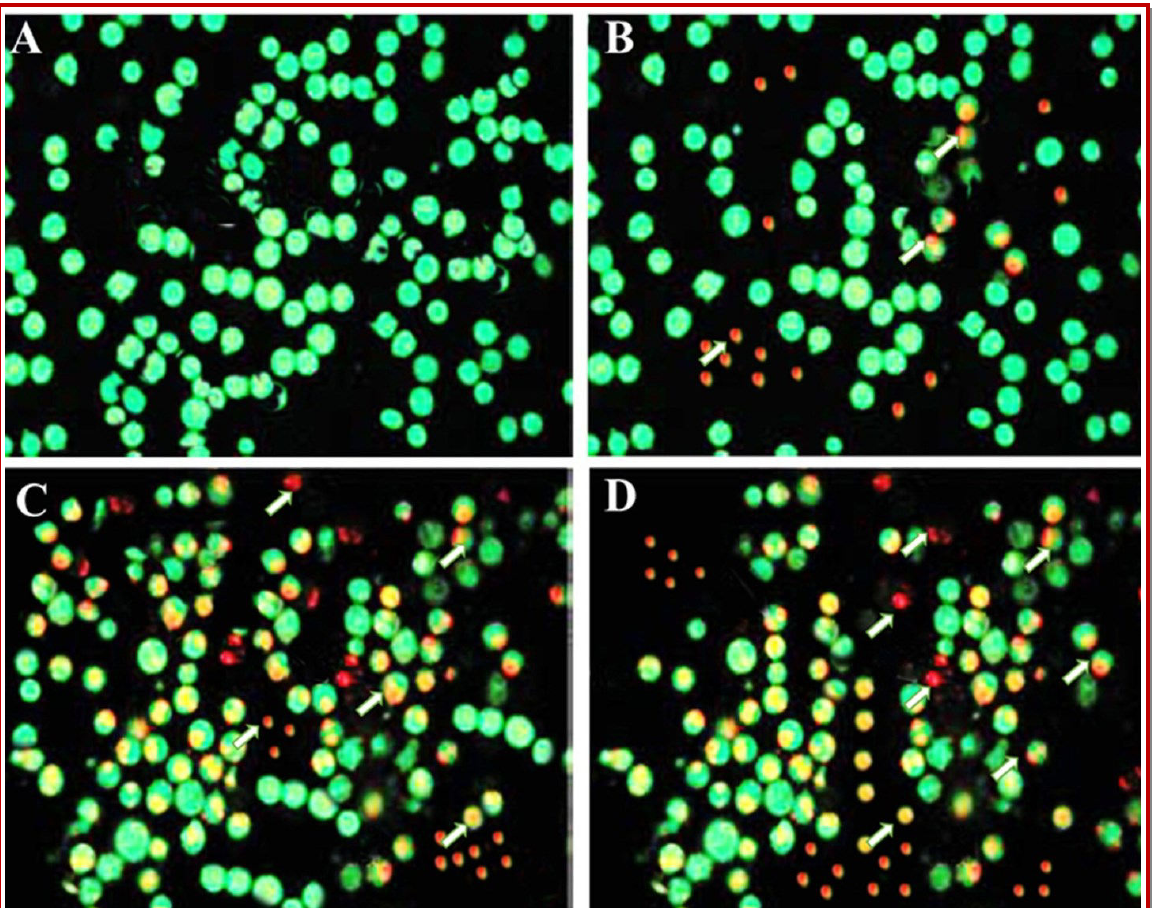
Figure 3: Fluorescence microscopic study of HL-60 cells using acridine orange/propidium iodide staining method. A, represents untreated control, B, C and D, represent HL-60 cells treated with 4, 32 and 128 µM dose of alloimperatorin epoxide respectively. The apoptotic cells (red fluorescence) indicated chromatin condensation or chromatin fragmentation (white arrows). The number of apoptotic cells (red color) increases with increase in alloimperatorin